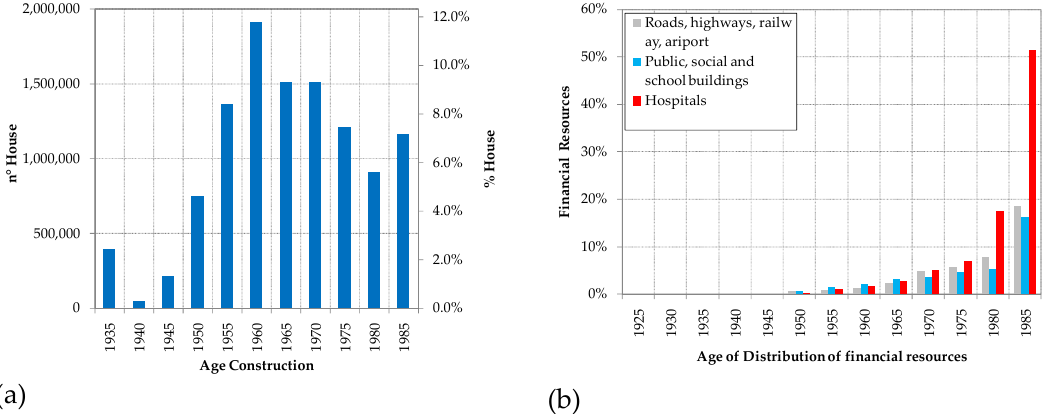
Figure 2. Residential buildings and main civil engineering works, according to the last Italian census involving both houses and construction: ( a ) distribution byage of houses built; ( b ) distribution of financial resources for engineering works totally or partially statefunded (source: www.istat.it). The age classes (construction or distribution of financial resources) considered are commonly used in socio-economic surveys and in post-earthquake surveys.